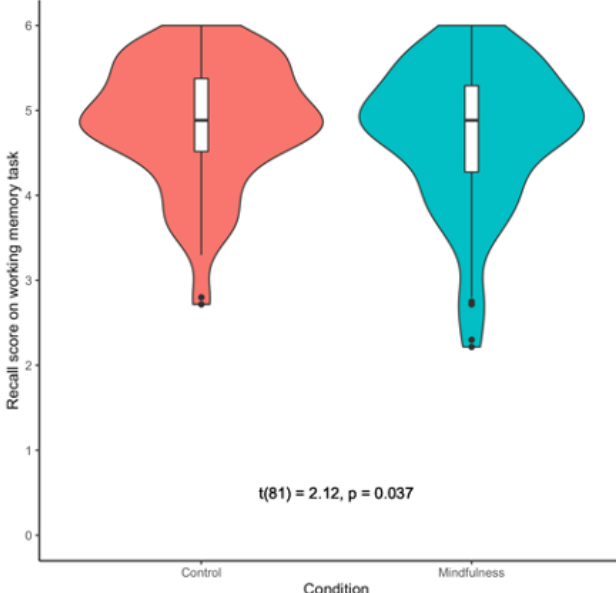
Figure 2. Violin Plots Depicting Working Memory Capacity in Study 1.